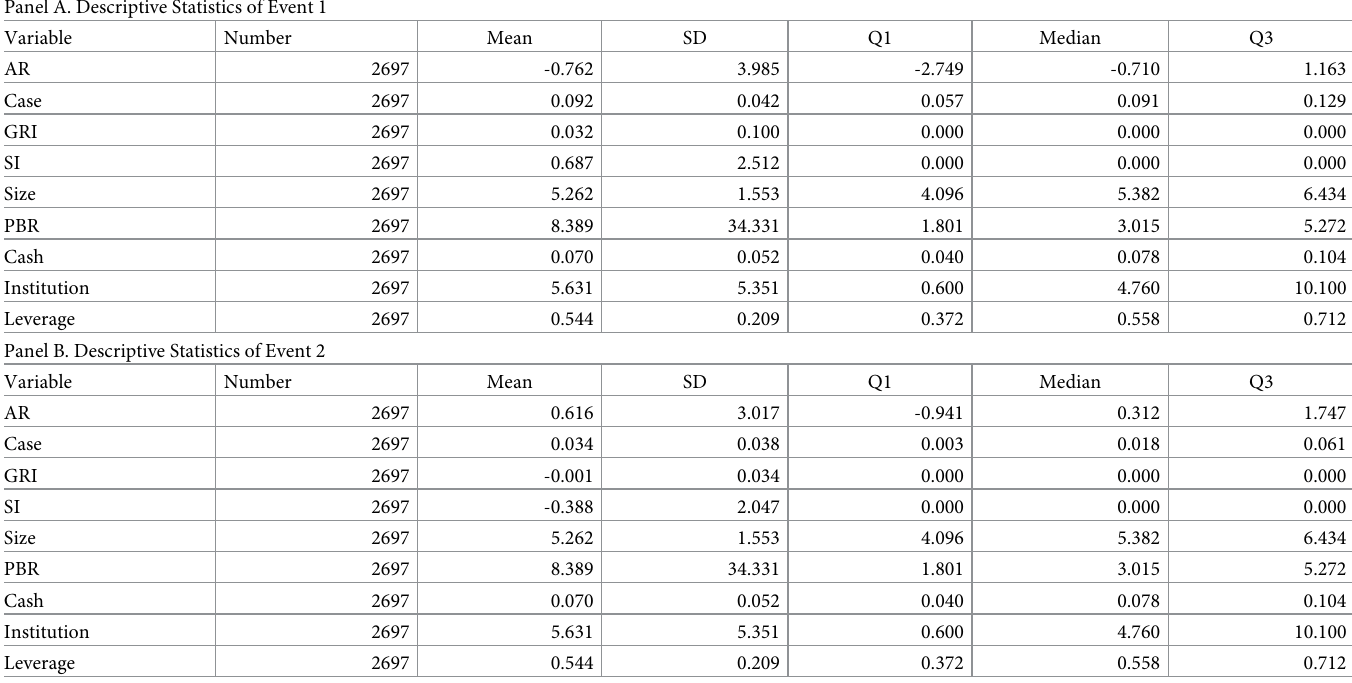
Table 3. Descriptive